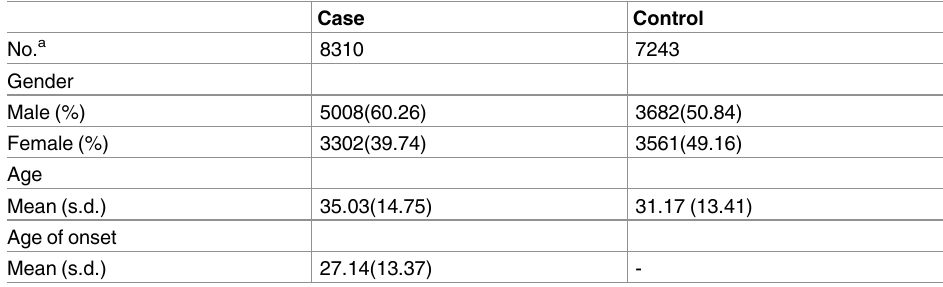
Table 1. The summaryinformation of